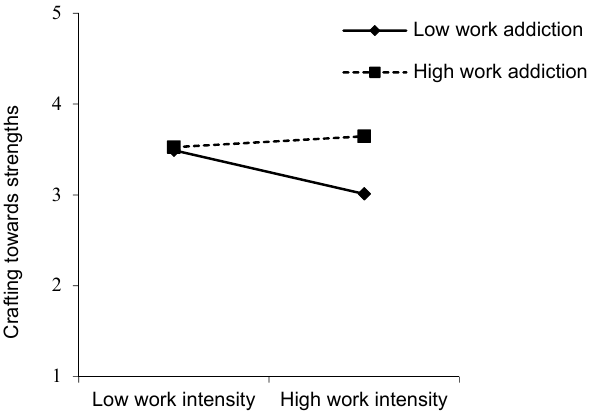
Figure 3. The interaction of work intensification and work addiction on crafting towards strengths.